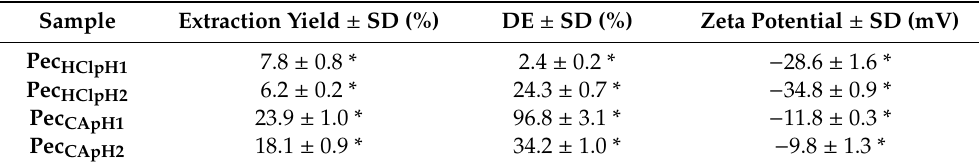
Table 1. E ff ect of acid type and pH on pectin